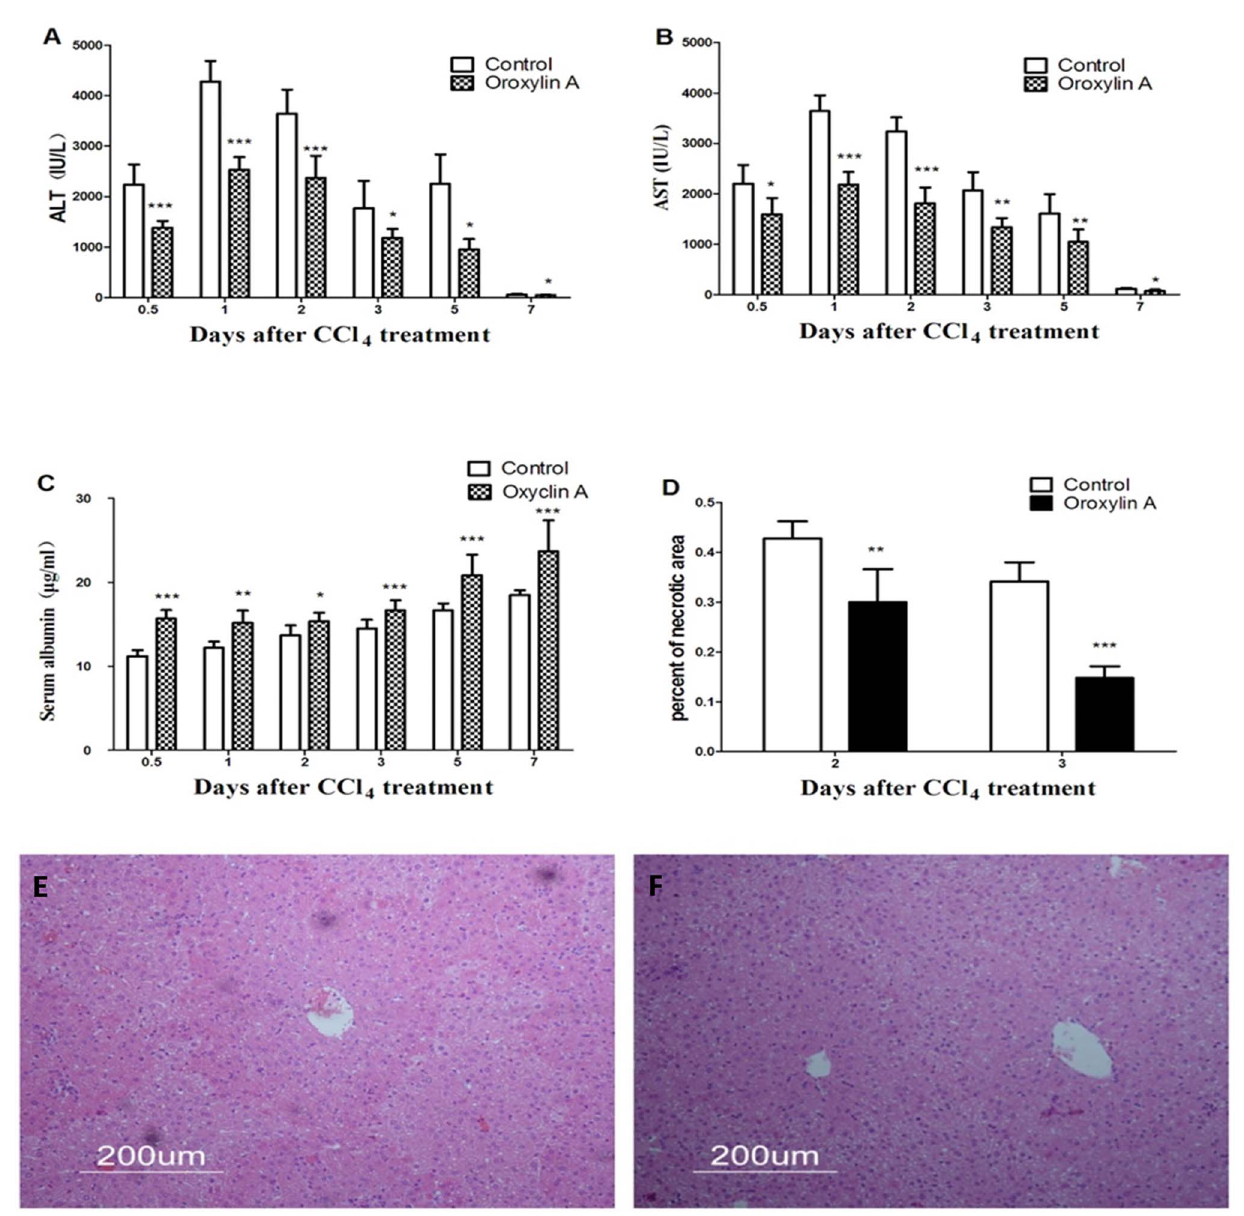
Figure 2. Oroxylin A protects liver against CCl 4 -induced acute liver injury. Mice were treated with CCl 4 (1 ml/kg body weight and 1:3 diluted in corn oil) to induce acute liver injury, then orally administered oroxylin A (60 mg/kg body weight and diluted in CMC-Na) 1 hour after CCl 4 injection, once per day for 4 days. Control mice were treated with an equal volume of CMC-Na. Subsequently, serum ALT, AST and Albumin were measured at indicated time points and determined as described in materials and methods. (A) Serum alanine aminotransferase (ALT). (B) Serum aspartate aminotransferase (AST). (C) Serum Albumin. (D) Percentage of necrotic areas in 6 oroxylin A groups were calculated at day 2 and day 3 after CCl 4 treatment. (E) Representative liver section of control group was stained with hematoxylin and eosin (HE) at day 3 after CCl 4 treatment, which shows partial necrosis with clusters of inflammatory cells around central vein. (F) Representative HE stained liver section of oroxylin A administration at day 3 after CCl 4 treatment, which demonstrates inflammatory cells were decreased and histological recovery with only inconspicuous necrosis still remained around central vein; Values represent mean 6 SE (n=6). (*), (**), and (***) for P , 0.05, P , 0.01 and P , 0.001